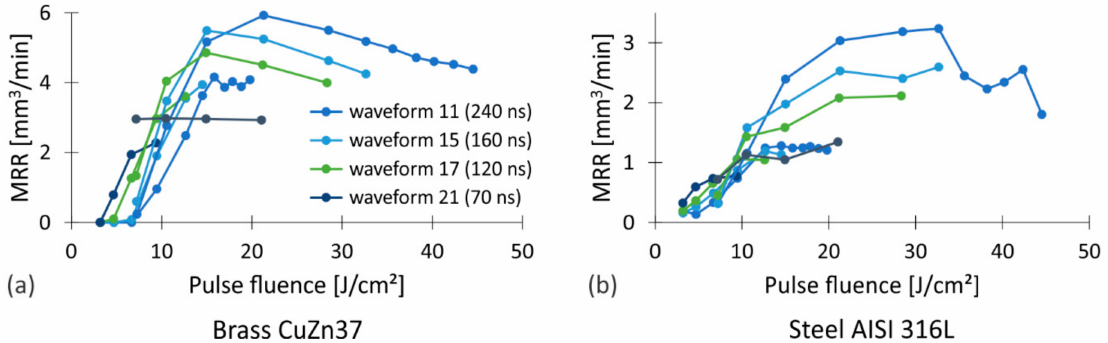
Figure 3. The evolution of the MRR as a function of the pulse fluence when processing ( a ) brass CuZn37 and ( b ) steel AISI 316L.